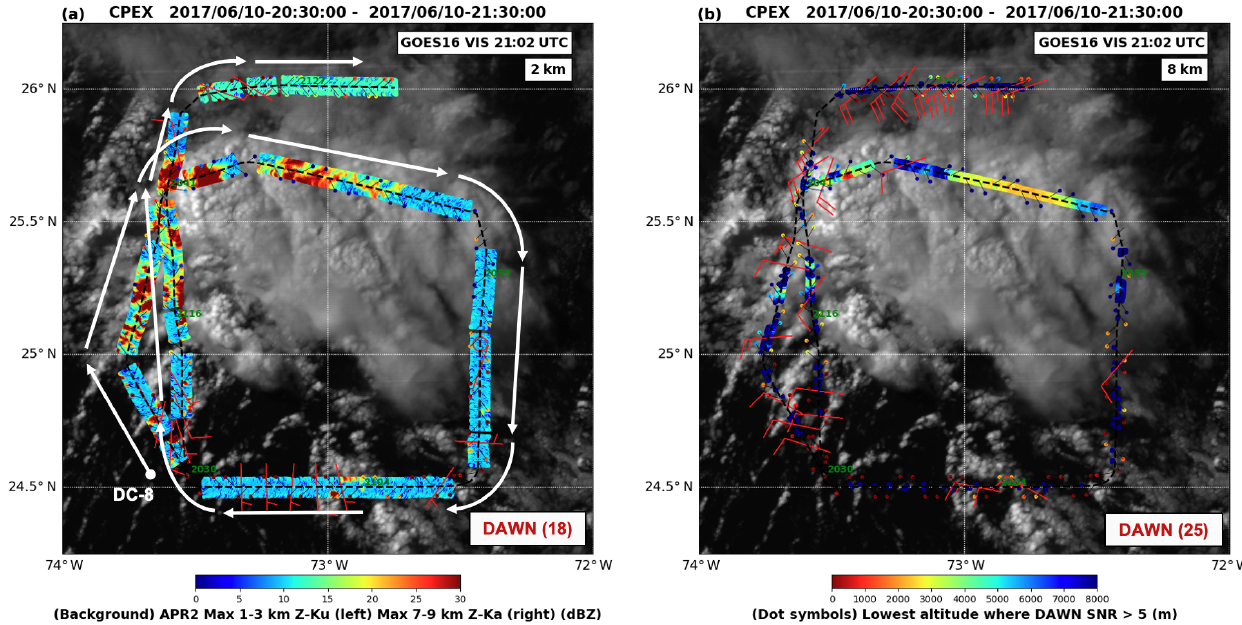
Figure 13. DC-8 flight line during segment 3 (20:30–21:30UTC) on 10 June 2017. Same layout and format as Fig.